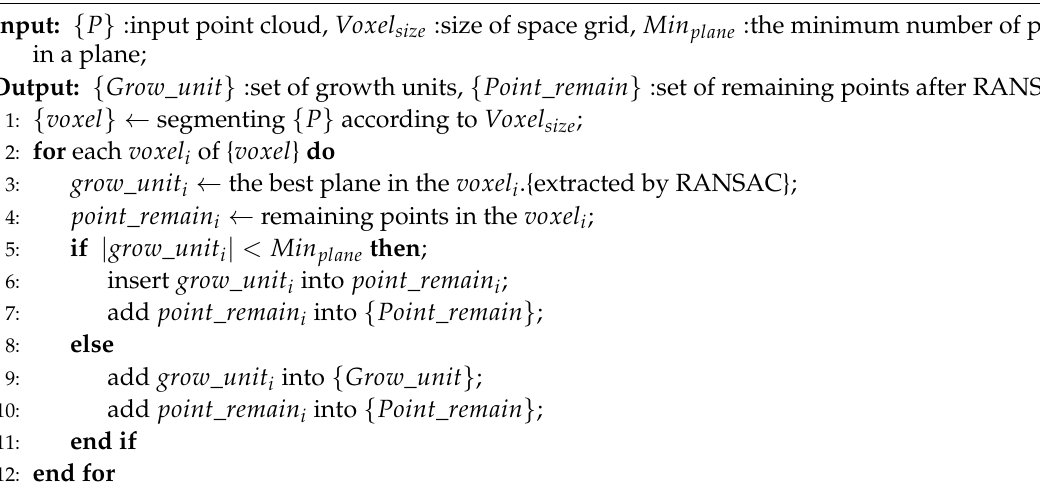
Algorithm 1 Coplanarity test based on